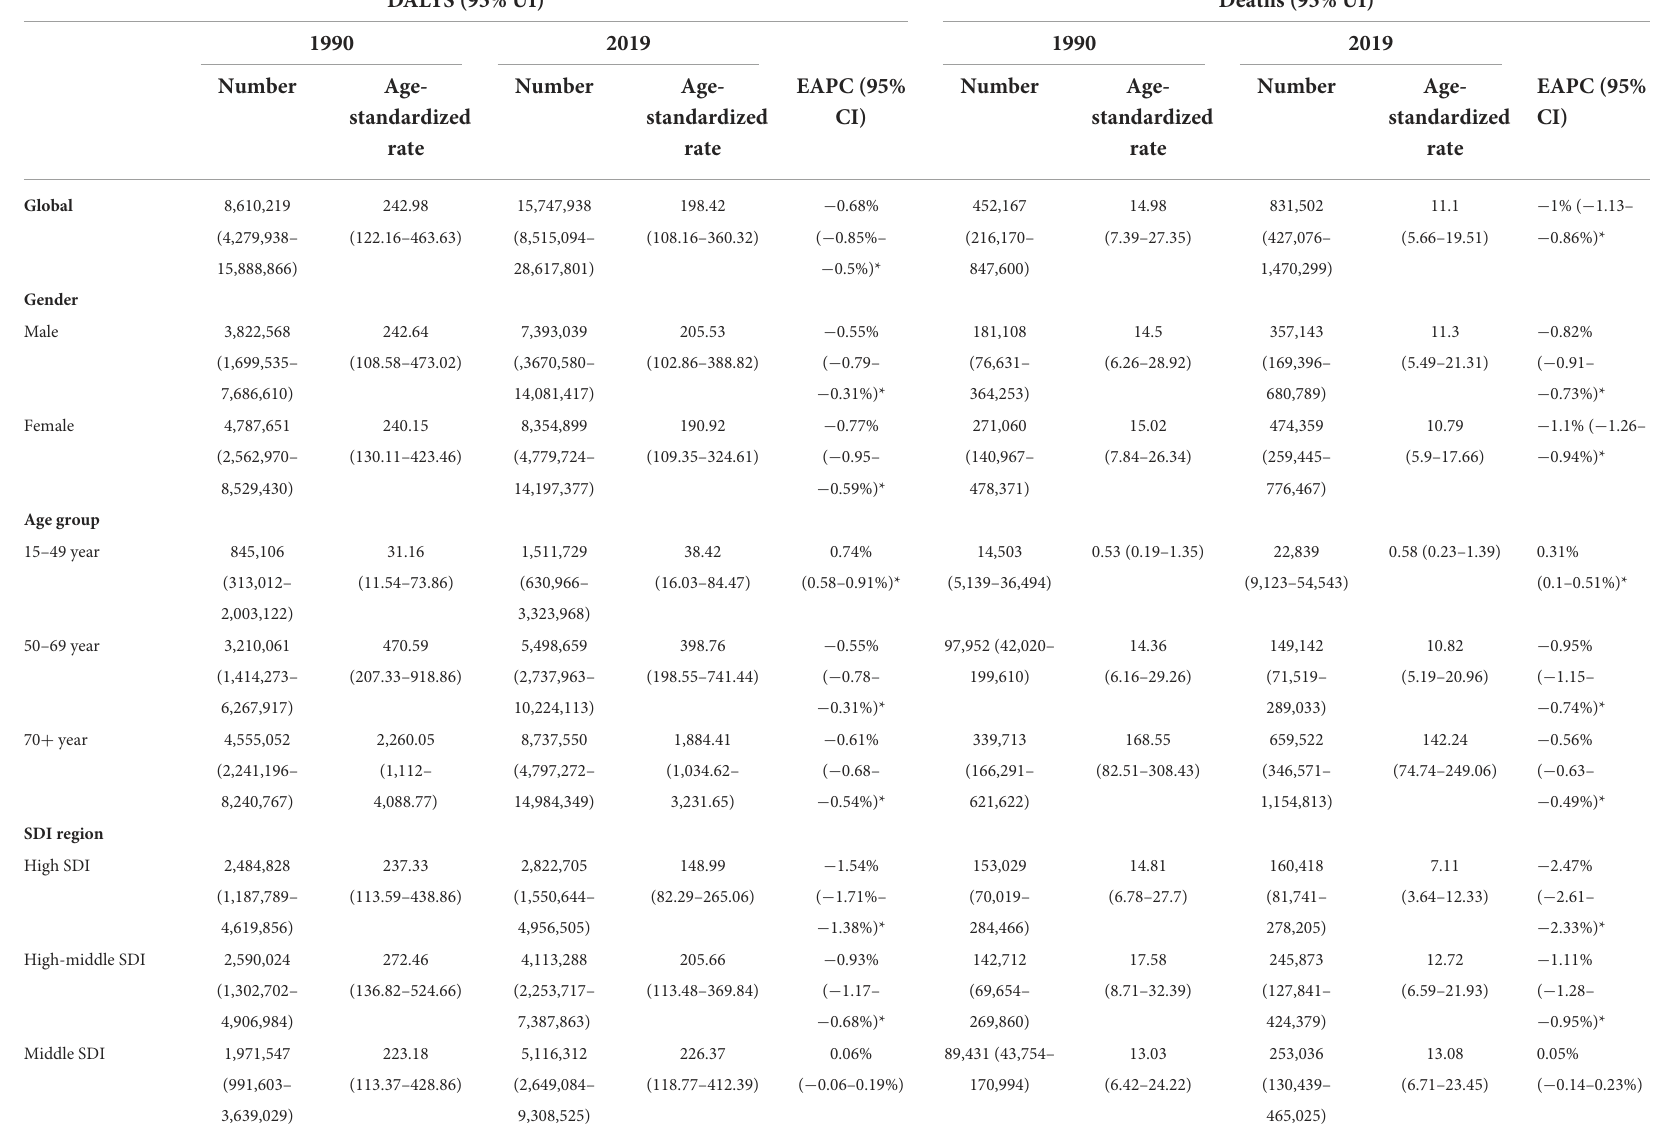
TABLE 1 The number and age-standardized rate of DALYs and deaths of disease attributable to low physical activity in 1990 and in